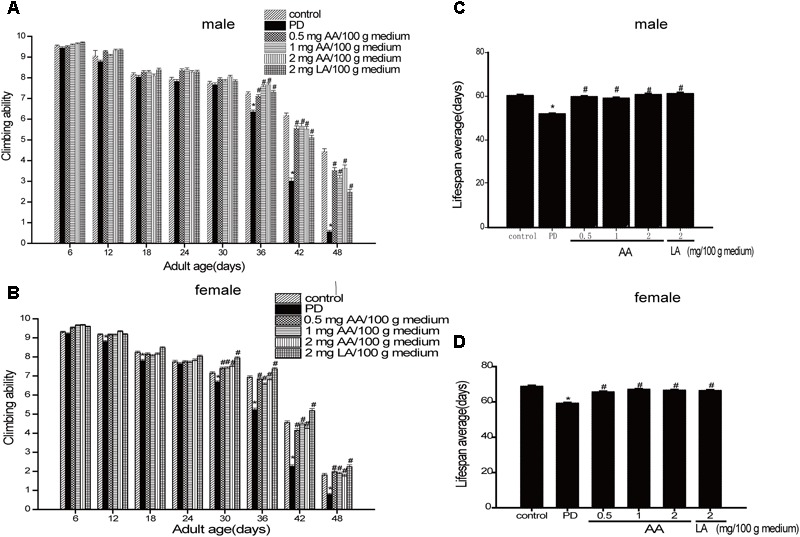
Neuroprotective effects of AA against α-syn-induced injury in α-syn transgenic PD drosophila. Control and a-syn transgenic PD Drosophila were divided into indicated groups, and the climbing ability and the number of dead drosophila were assayed on indicated day. AA promotes climbing in α-syn transgenic PD drosophila (N = 230; ∗p < 0.05 vs. non-PD group; #p < 0.05 vs. PD group) for (A) male and (C) female Drosophila melanogaster (average). AA prolongs the life-span of α-syn transgenic PD drosophila in (B) males and (D) females (mean ± SEM, N = 230; ∗p < 0.05 vs. non-PD group; #p < 0.05 vs. PD group)).